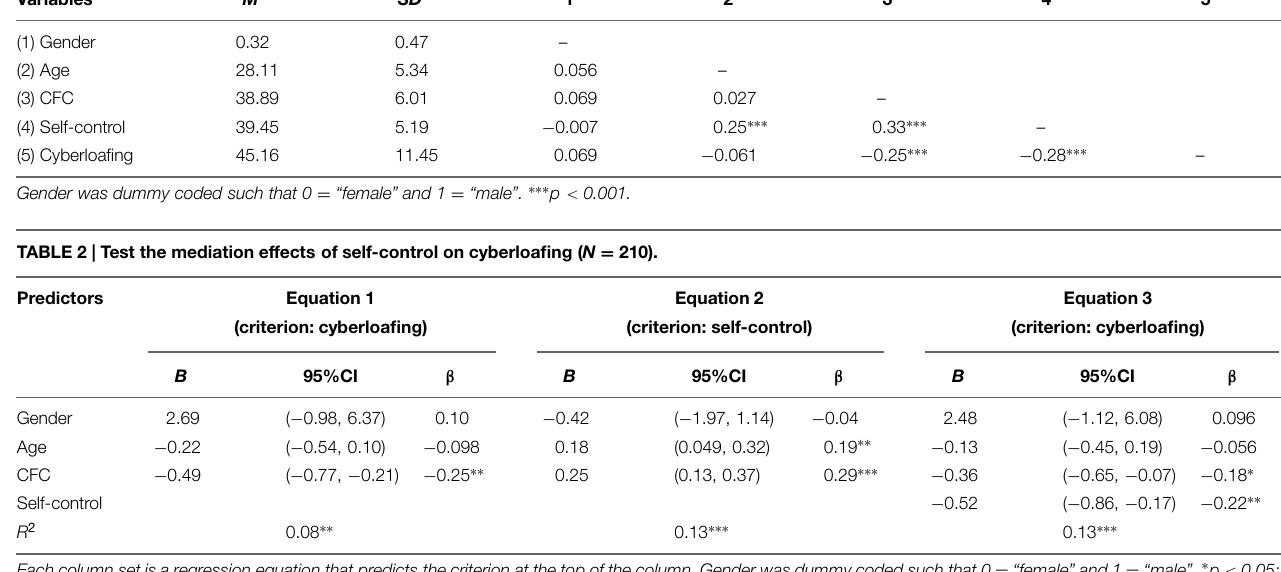
TABLE 1 | Descriptive statistics and intercorrelations between the variables. Variables